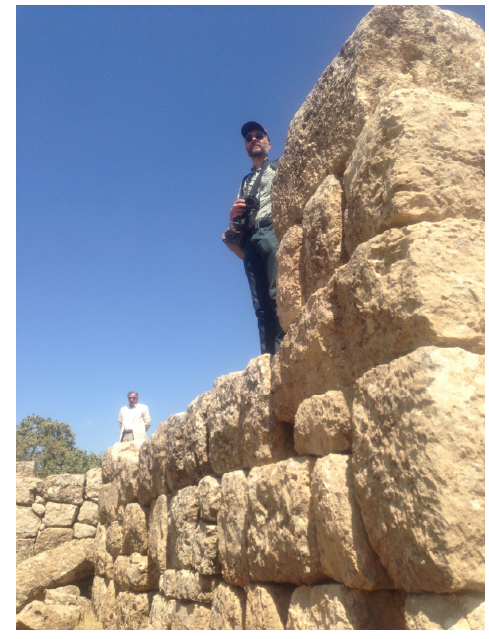
Fig. 5. The entrance to the Upper Town of Keferde with a tower. View from the south. Photo: Minna Silver